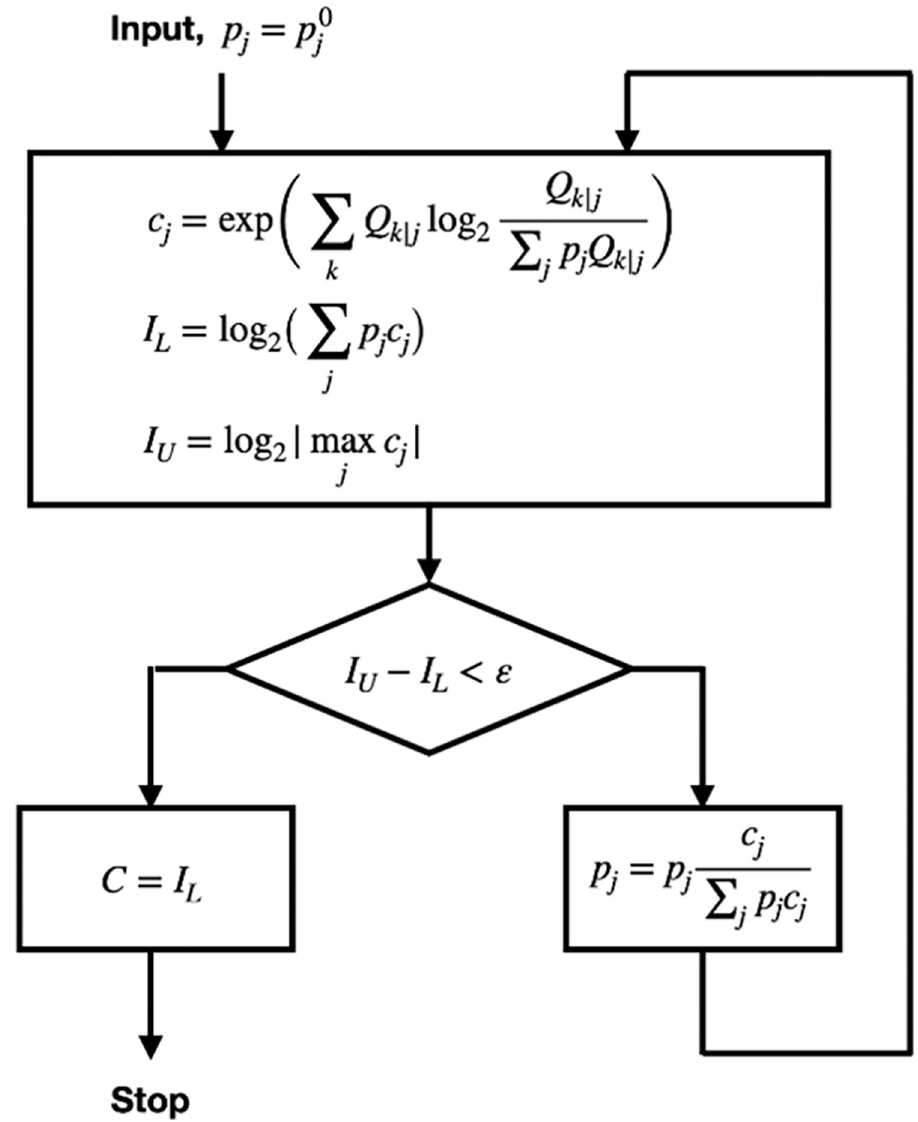
Fig 4. Flowchart of the Blahut-Arimoto algorithm to compute channel capacity (adapted from Blahut, 1972 [18]).